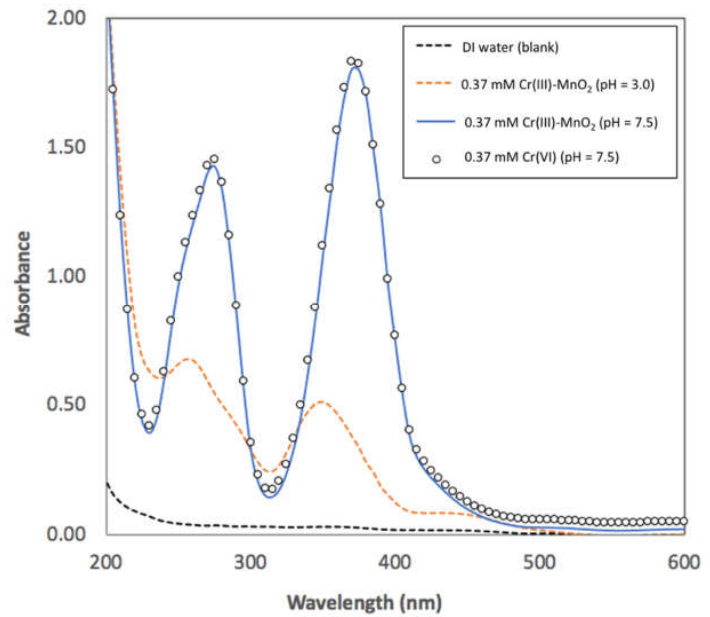
Figure 6. UV–Vis spectra of the Cr(III)–MnO 2 reaction solution (pH = 3.0) and the same solution adjusted to pH = 7.5 with NaOH. A 0.37 mM Cr(VI) standard prepared at pH = 7.5 is also shown. Crystals 2021 , 11 , x FOR PEER REVIEW To visualize the Cr(III) oxidation reaction and provide an approximate time course measurement, a set of samples containing 0.50 g MnO 2 and 20 mM Cr(III) or Cr(VI) were